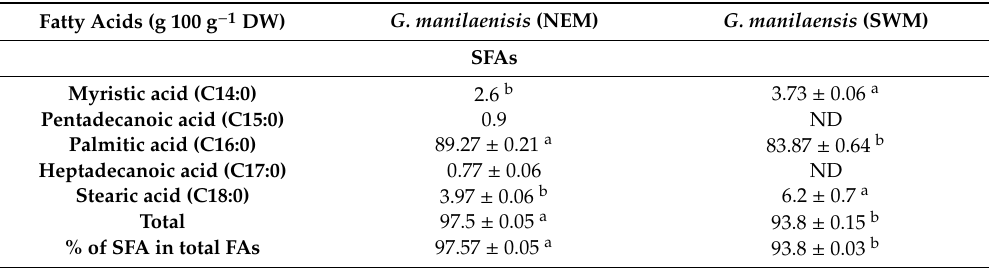
Table 2. Variation in the Fatty Acid Composition (g Fatty Acid Methyl Esters / 100 g Total Fat) of G. manilaensis